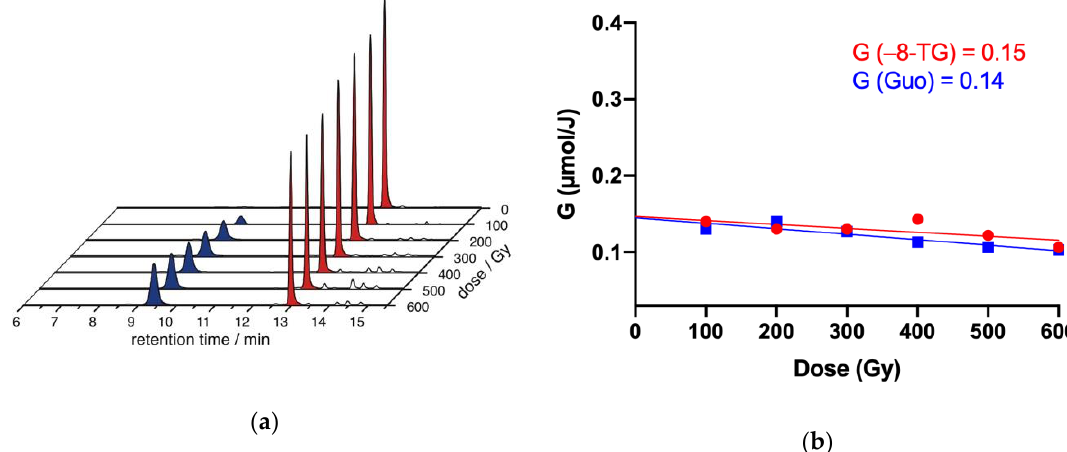
Figure 8. γ -radiolysis of 1 (0.25 mM) in N 2 -purged water at a natural pH, containing t BuOH (0.25 M) at a dose rate of 1.85 Gy · min − 1 . ( a ) HPLC runs of the reactions. The HPLC peaks of 1 are highlighted in red, while the peaks of guanosine ( 2 ) are highlighted in blue. ( b ) The chemical irradiation yields G ( − 1 ) ( (cid:8) ) and G ( 2 ) ( (cid:4) ) as function of the irradiation dose. The line extrapolated to the zero dose leads to the G values reported in the graph.